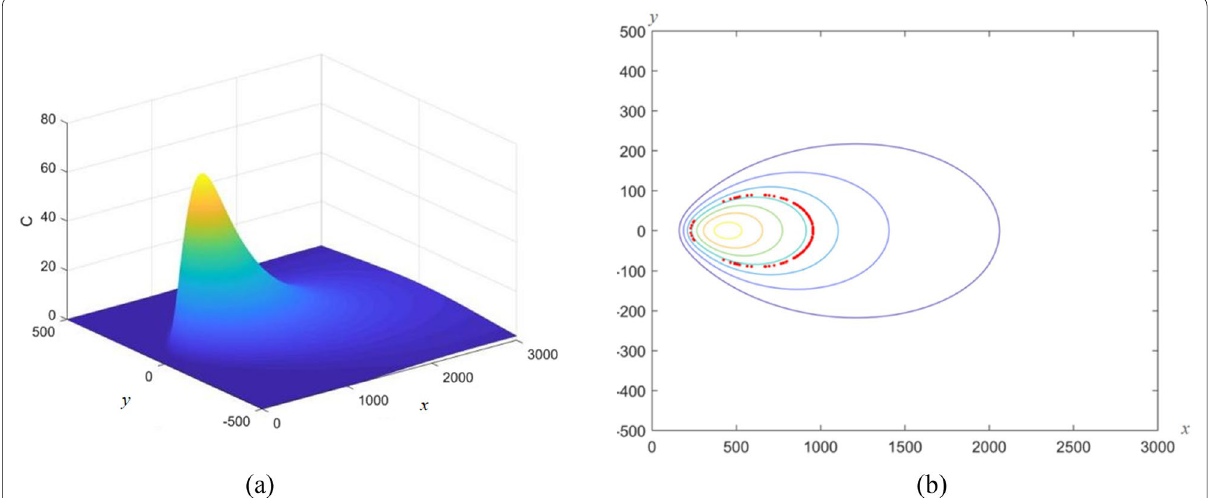
Fig. 4 a Gas diffusion concentration distribution. b Isoconcentration diagram of gas diffusion in XOY